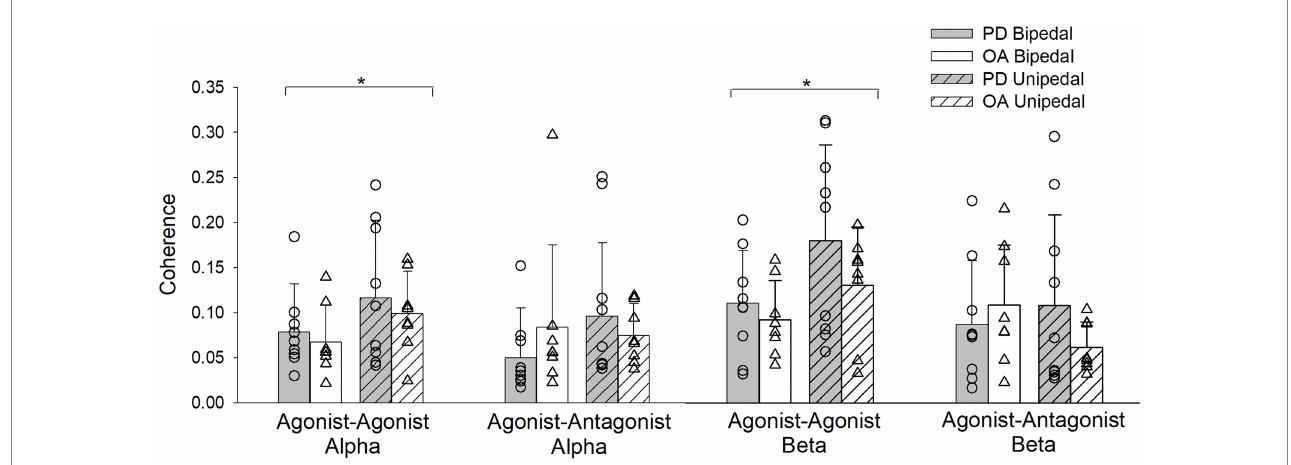
FIGURE 4 Alpha and Beta band coherence for pooled agonist–agonist and agonist–antagonist muscle pairs during bipedal (open bars) and unipedal stances (hatched bars) for older adults with Parkinson’s disease (PD, gray bars) and older adults without PD (OA, white bars). *, bipedal differs from unipedal within the agonist–agonist alpha and beta coherence bands for older adults with PD and older adults without